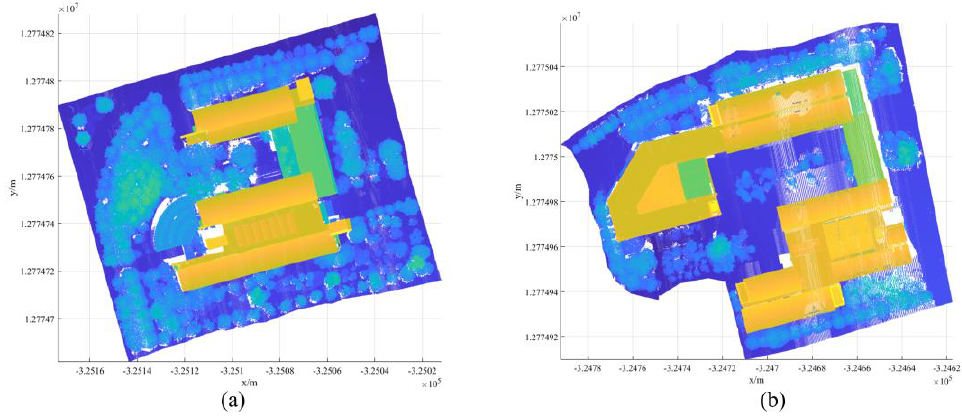
Figure 1. Schematic diagram of experimental objects. ( a ) Plot 1; ( b ) Plot 2.